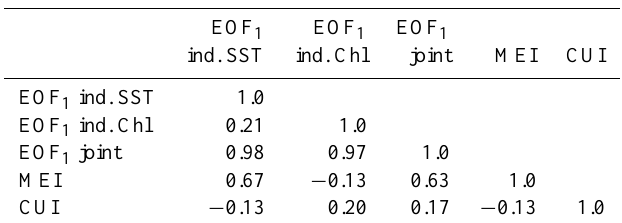
Table 1. Correlation coefficients between principal components from different SST and chlorophyll a EOF 1 analyses (individual (ind.) and joint) and MEI and monthly CUI anomalies using the original time series ( N =